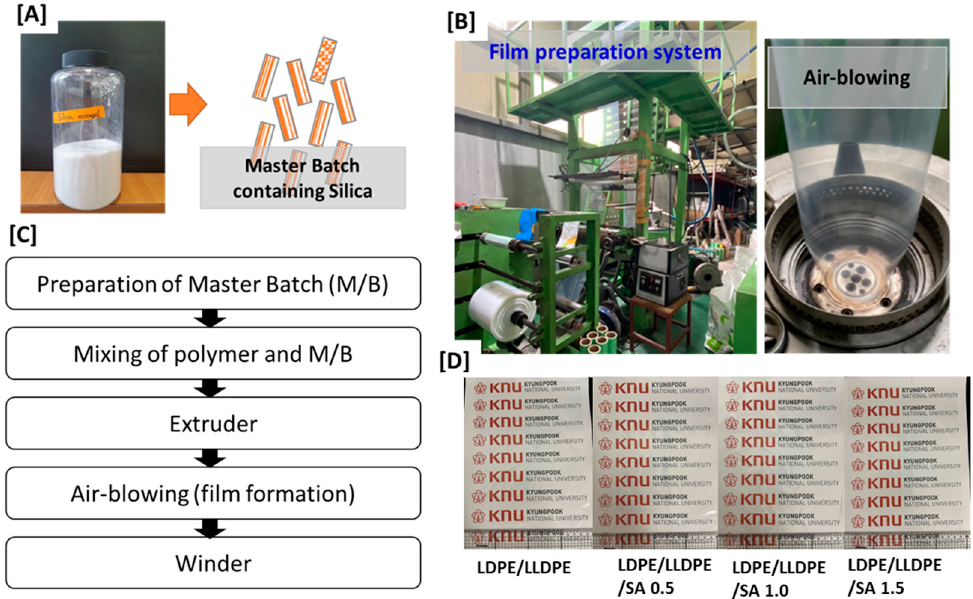
Figure 1. A demonstration of the experiment. ( A ) SA powder and masterbatch containing SA; ( B ) film preparation system at the pilot scale; ( C ) diagram showing the preparation of the air blown film; and ( D ) a macro photograph of the prepared films.